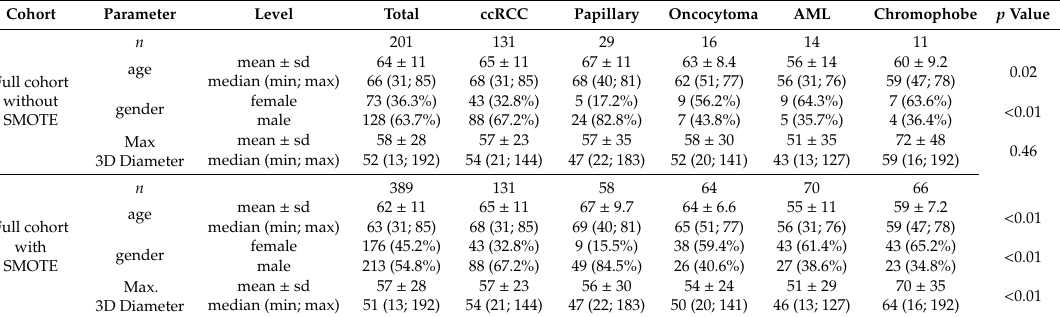
Table 1. Di ff erences in patient age, gender, and largest three-dimensional (3D) diameter according to renal tumor subtype in the full cohort without and with the synthetic minority oversampling